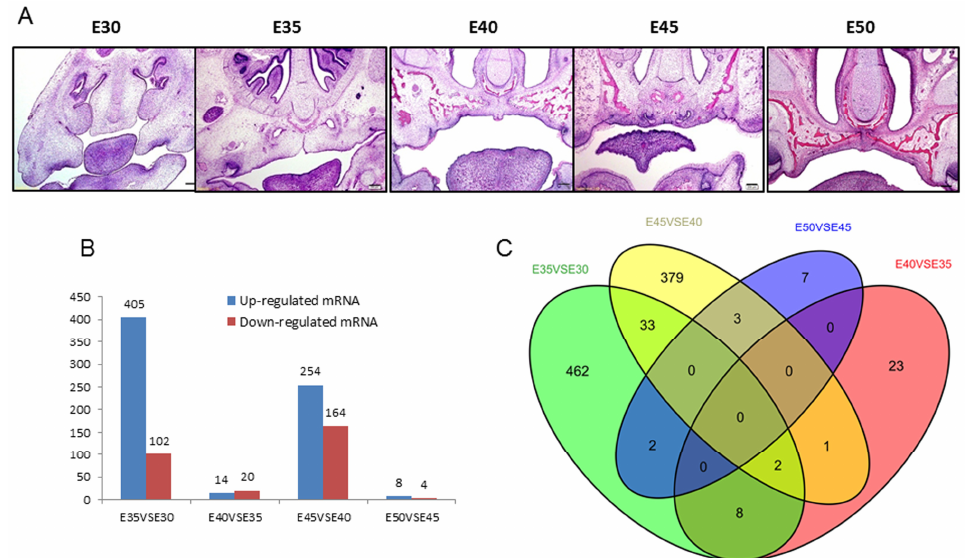
Figure 1. Gene expression profiles in secondary palate morphogenesis. ( A ) The palate development of miniature pigs from E30–50. Scale bar, 200 μm. ( B ) The differential expression genes between stages from E30–50. ( C ) Venn diagrams showing the numbers of transcriptional alterations between stages.